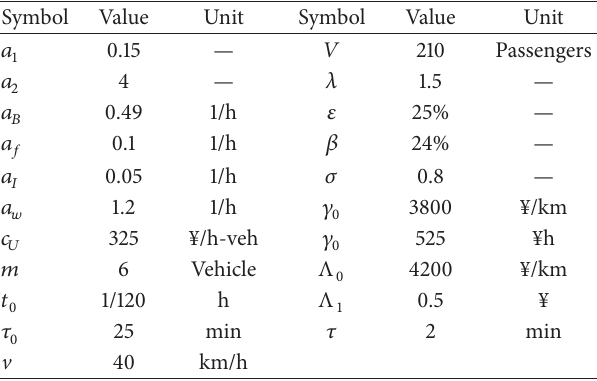
Table 1: Baseline values for